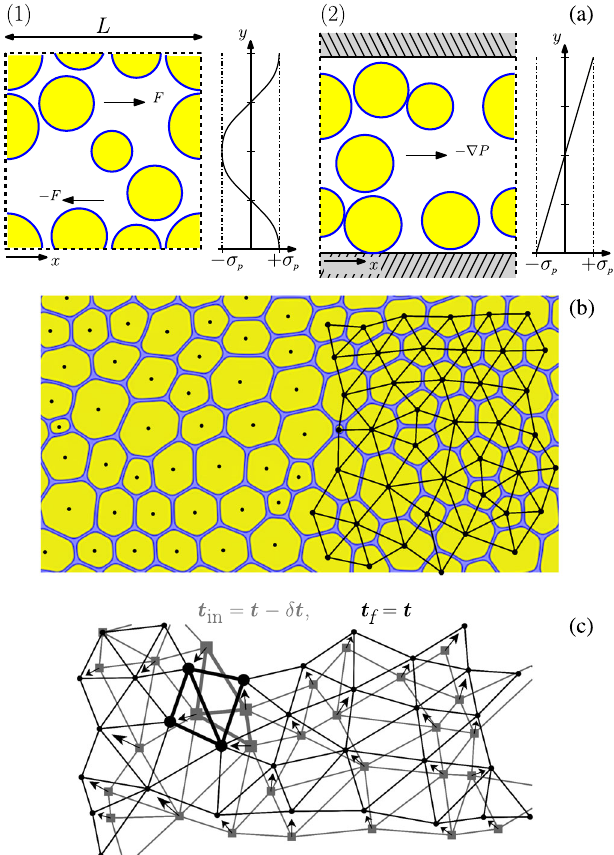
FIG. 1. Sketch depicting the fundamental quantities used in our analysis. (a) Flow setups and relative stress profiles: (1) Kolmo- gorov flow on fully periodic square domain of size L ; (2) pres- sure-driven flow with streamwise periodic boundary on a square domain. (b) Density field of the simulated soft-glassy model: Deformable droplets in yellow are jammed together in a con- tinuous phase (light blue); the droplets ’ centers of mass are indicated with a dot and are connected in their Delaunay triangulation [58,59] in the right half of the panel. (c) Comparison between two successive Delaunay triangulations at initial time t in (gray color with squared points) and final time t (black color f with round points): Arrows indicate the value of the displacement ⃗ Δ ð t Þ [see Eq. (4)] at each droplet; the region where a plastic field i rearrangement occurs (i.e., an edge flip in the triangulation [59]) is highlighted with thicker